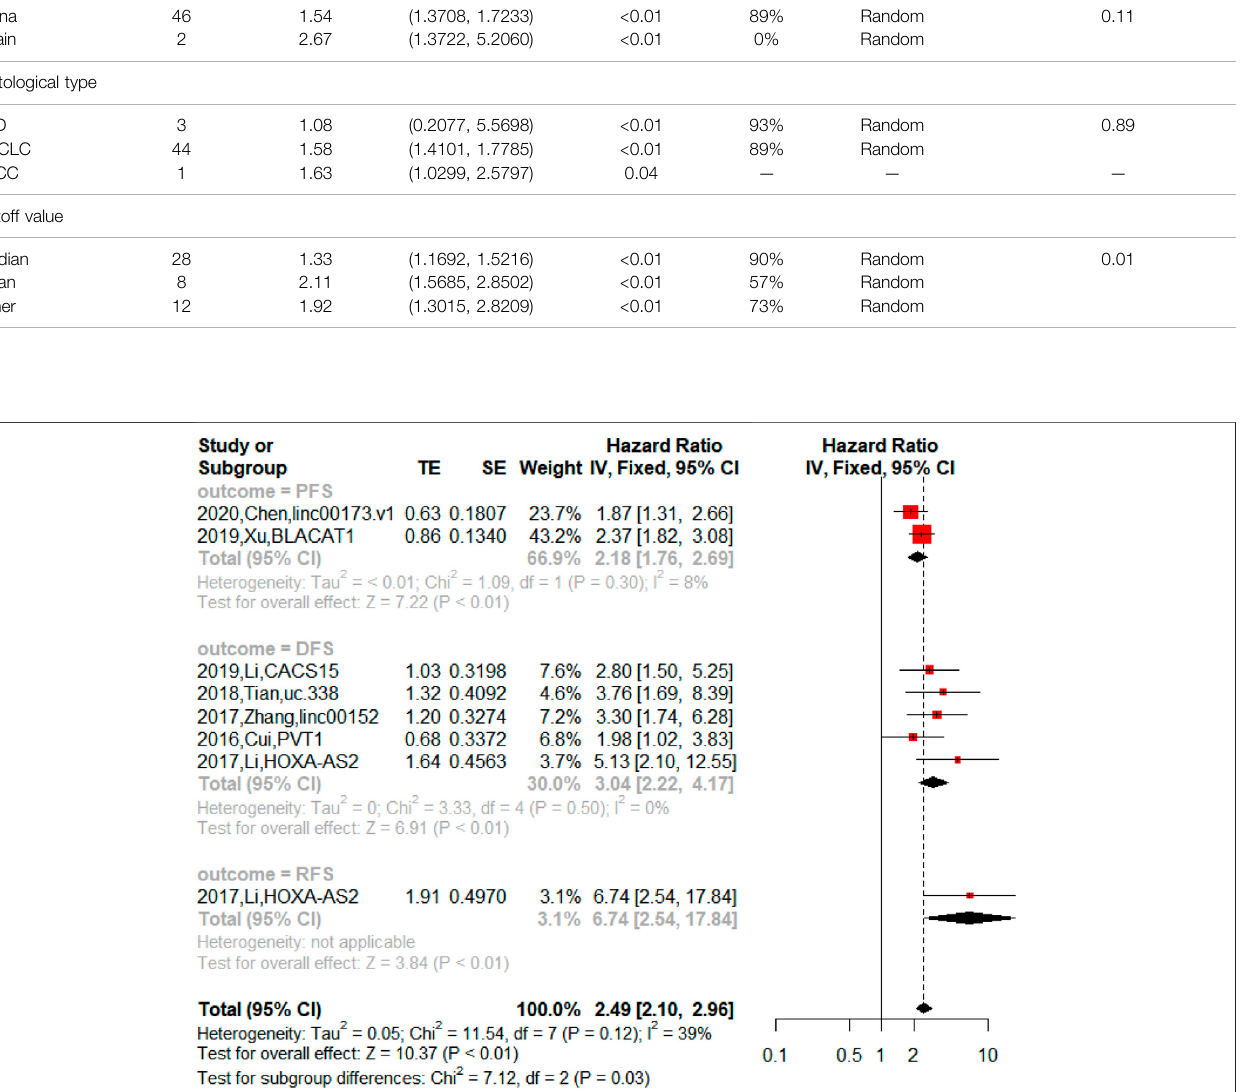
Frontiers in Genetics |